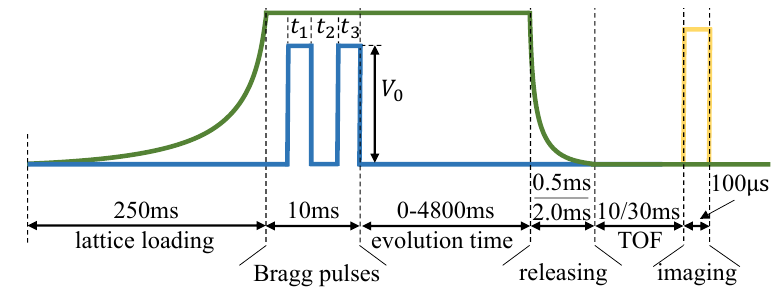
Figure 2: Experimental sequence (not to scale). Green: lattice depth as a function of time. The lattice is turned off in 0.5 ms for measuring the longitudinal MDF and in 2 ms for measuring the transverse excitation. Blue: Bragg pulses characterized ] . Yellow: imaging pulse by the pulse intensity V and the time sequence [ t , t , t 0 1 2 3 applied after a TOF of 10 ms (for N = 40) or 30 ms (for N = 130).